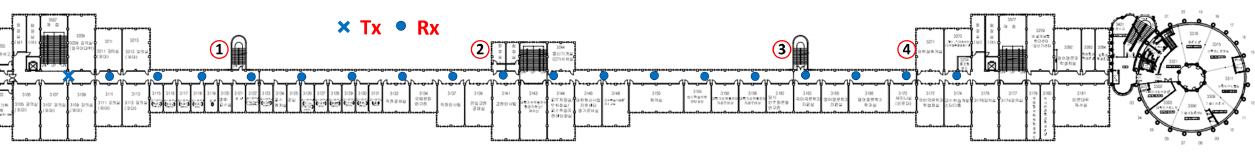
Figure 3. The experimental outlet is on the 3rd floor of the main building corridor. Structures that create irregularities in the corridor are marked with circled numbers: 1 (cid:13) ; 2 (cid:13) ; 3 (cid:13) ; and 4 (cid:13)